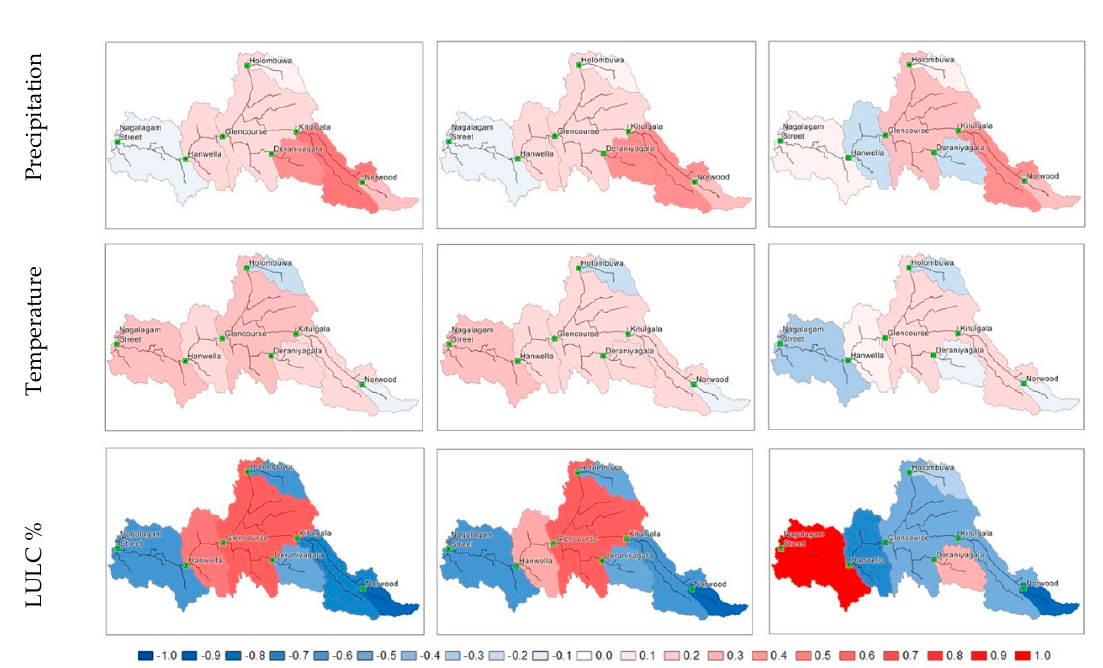
Figure 7. Hydro-Metrological and LULC correlation with each subbasin.